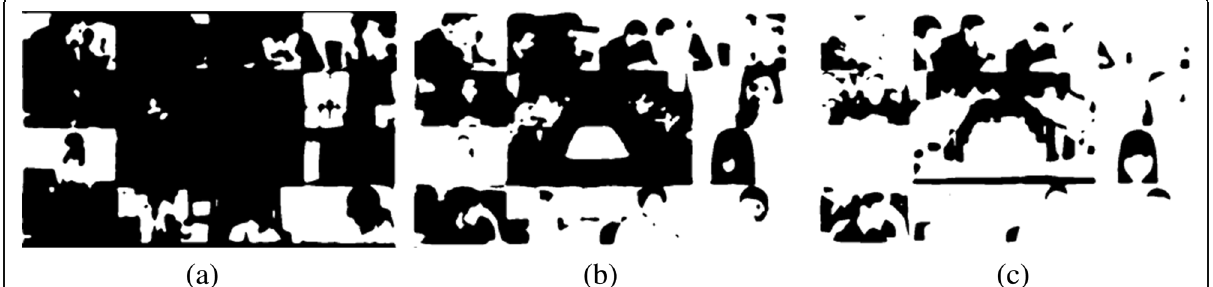
Fig. 6 a – c Comparison of image edge recognition